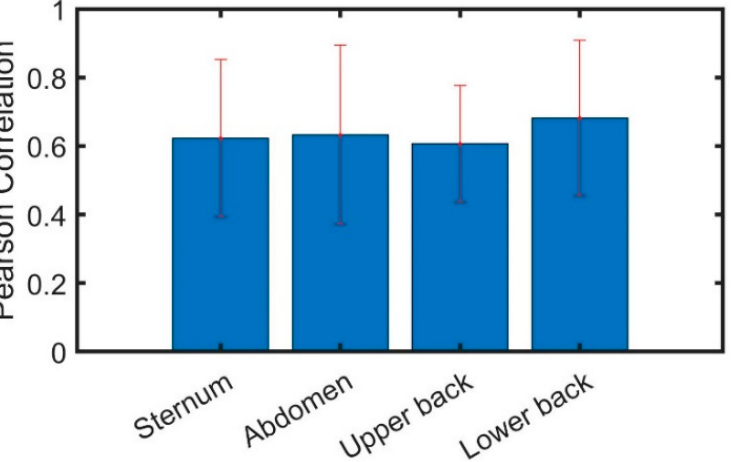
Figure 5. Average cross-correlation between the smartphone and the force plate across different device locations: (1) sternum, (2) abdomen, (3) upper back, and (4) lower back. Figure 6 qualitatively compares the raw signals of the FP and the smartphone at different locations and demonstrates the similarity between three static balance positions at different levels of